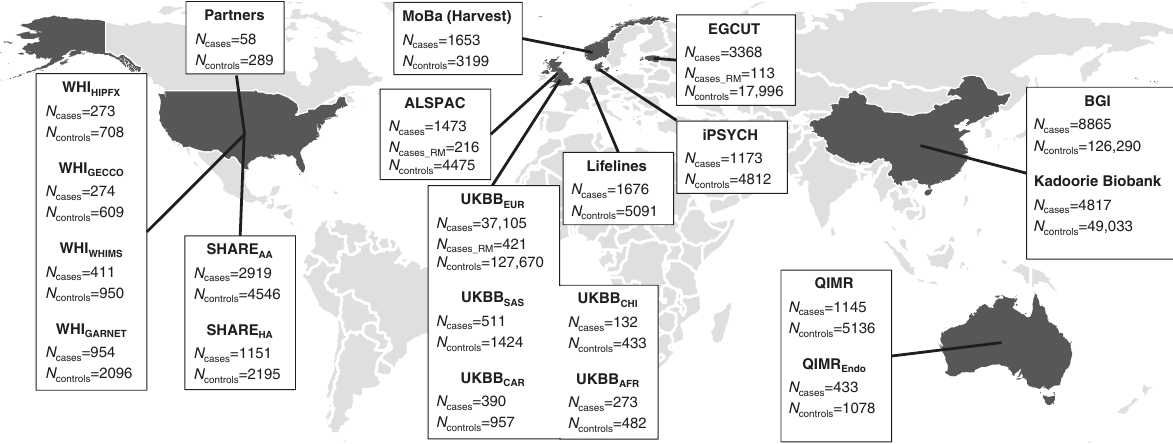
Fig. 1 Overview of the included cohorts. Our trans-ethnic GWAS meta-analysis for sporadic miscarriage included data for 69,054 cases and 359,469 female controls, whereas our European ancestry only analysis included 49,996 sporadic miscarriage cases and 174,109 female controls. We also analyzed data for 750 multiple consecutive miscarriage cases, all of European ancestry.